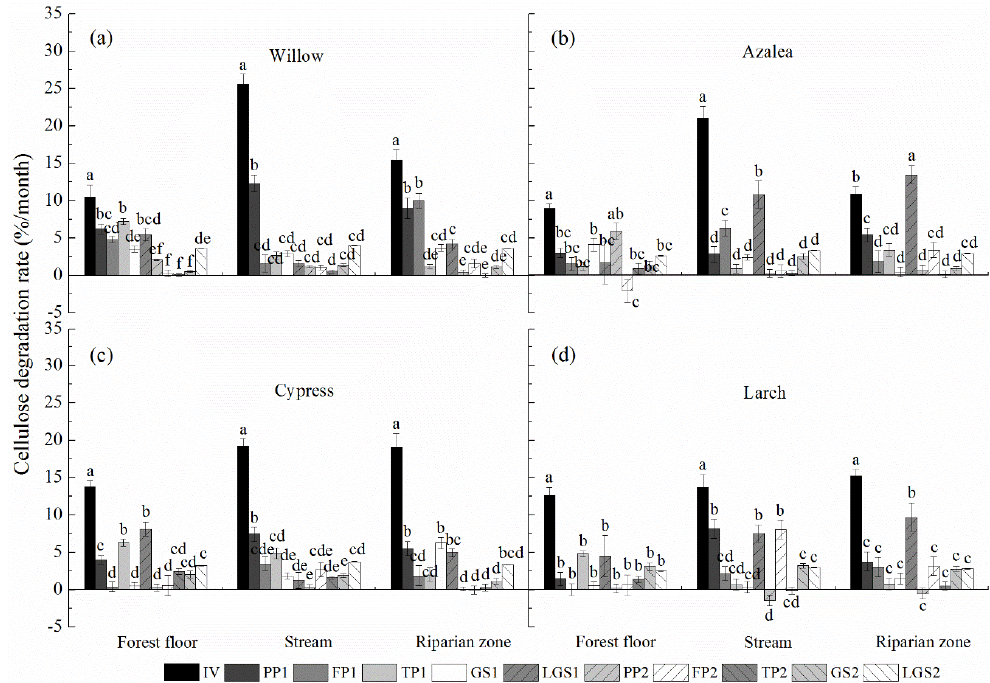
Figure 3. Dynamics of cellulose degradation rate (percent initial mass per month, %/month) in decomposing foliar litter of ( a ) willow; ( b ) azalea; ( c ) cypress; and ( d ) larch in different ecosystem types during the two ‐ year experiment (mean ± SD, n = 9). Different lowercase letters indicate statistically significant ( p < 0.05) differences of cellulose degradation rate among different decomposition periods for a given litter species in a specific type of ecosystem. IV: initial value; PP: pre ‐ freezing period; FP: freezing period; TP: thawing period; GS: growing season; LGS: late growing season; 1: the first year;